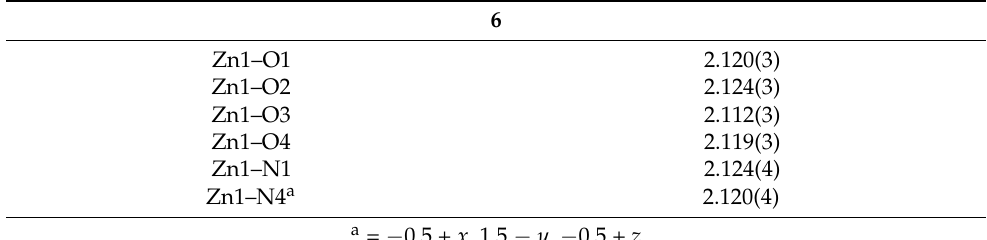
Table 4. Selected bond lengths (Å) for compound 6 .